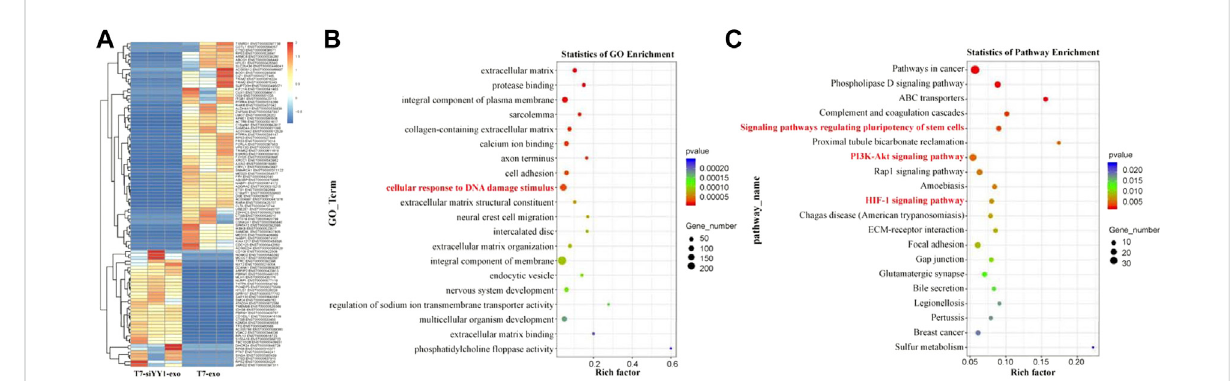
FIGURE 4 Molecular mechanism of T7-siYY1-exo. (A) RNAsequencing wasperformedon T7-siYY1-exo treated cells. (B) Geneontology (GO) enrichment analysis enrichment of differential genes after T7-siYY1-exo treatment. (C) KEGG bioinformatics analysis of differential genes after T7-siYY1-exo